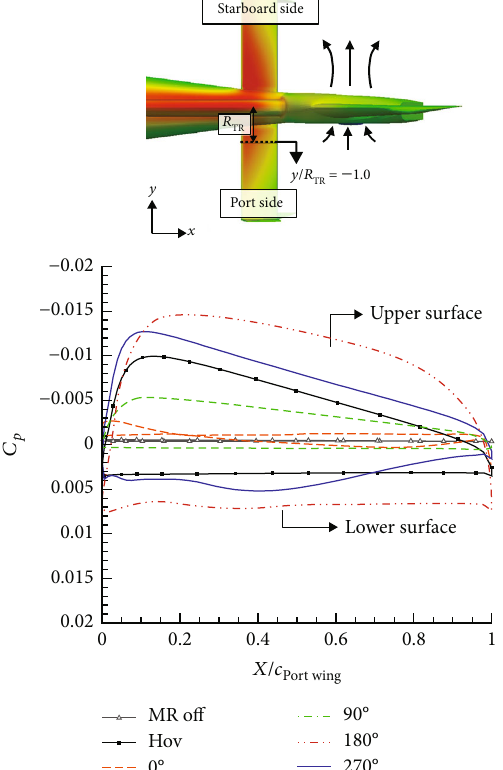
Figure 10: Time-averaged pressure coe ffi cient on the port wing at y/ R = − 1 : 0 TR